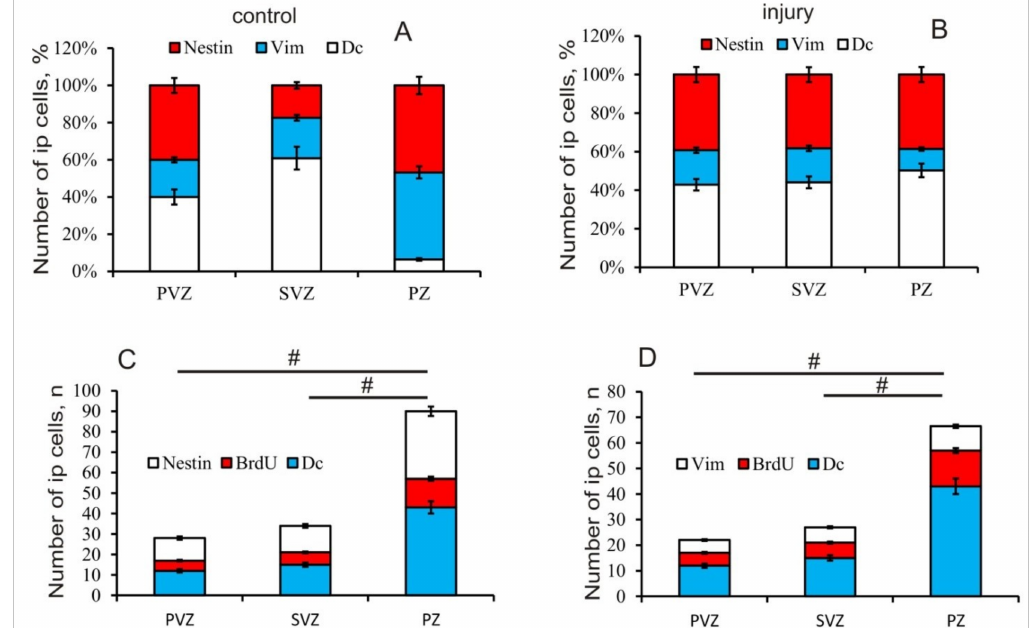
Figure 9. The quantitative ratio of expression of IHC markers of proliferation, NPCs, and neuroblasts, in the intact mesencephalic tegmentum of juvenile chum salmon, Onchorhynchus keta , and on day 3 post-injury. ( A ) Expression of nestin, vimentin, and doublecortin in PVZ, SVZ, and PZ in the control (M ± SD). ( B ) After traumatic injury (M ± SD). ( C ) The ratio of nestin + , BrdU + , and DC + cells in di ff erent areas of the chum salmon tegmentum after damage ( n = 5 in each group; # are significant intergroup di ff erences); one-way analysis of variance (ANOVA). ( D ) The ratio of Vim + , BrdU + , and DC + cells in di ff erent areas of the chum salmon tegmentum after damage ( n = 5 in each group; # are significant intergroup di ff erences); one-way analysis of variance